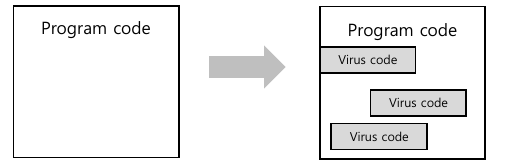
Fig. 4. The example of an infection by an overwriting